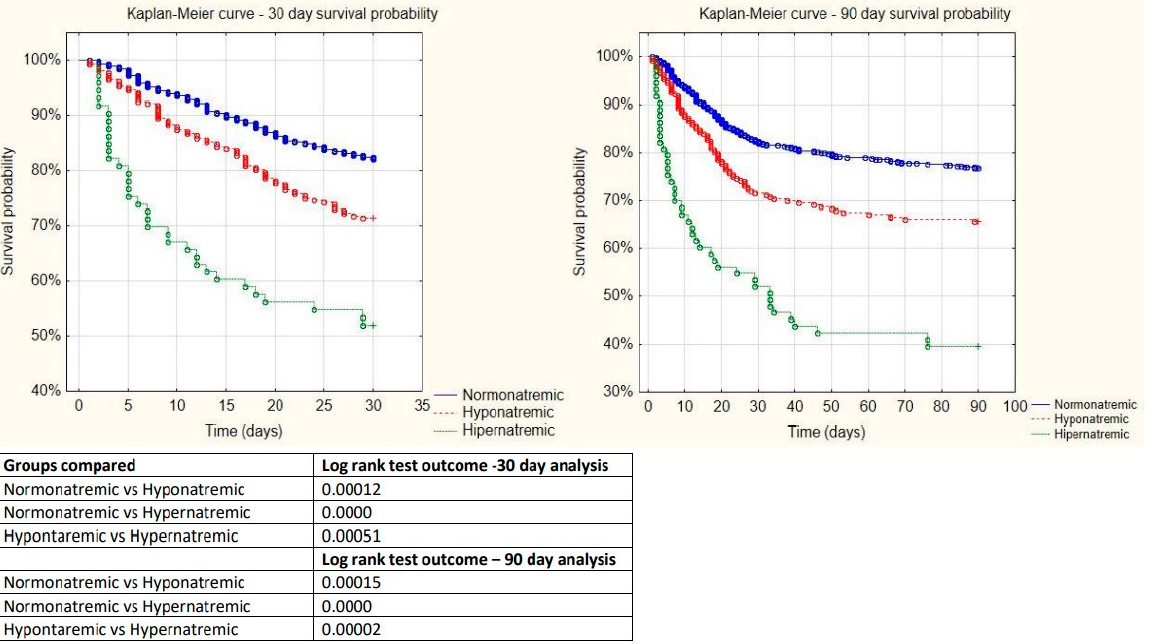
Figure 1. Kaplan–Meyer curves for 30- and 90-day mortality and results of the log-rank tests.